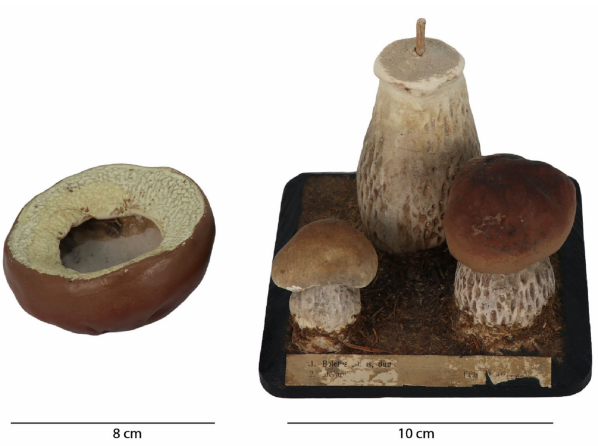
Figure 2. Model Boletus edulis, Bull. model ( right ) and the detached cap ( left